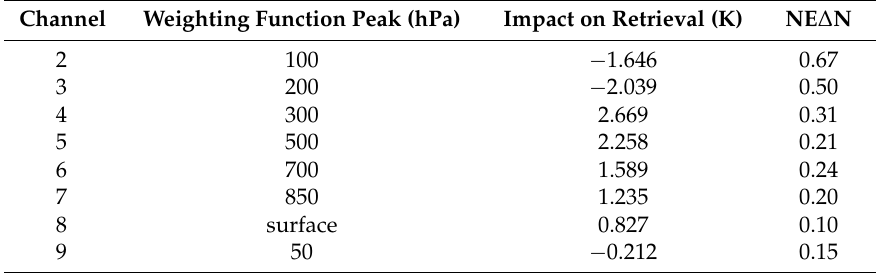
Table 2. Sensitivity test of temperature sounding channel noises on the retrievals. The impact is based on adding 0.5 K noise to individual channel brightness temperatures. The levels shown are the approximate peaks of individual channels’ weighting functions. The NE ∆ N values (mW/(m 2 ¨ sr ¨ cm ´ 1 )) are taken from NOAA KLM User’s Guide.